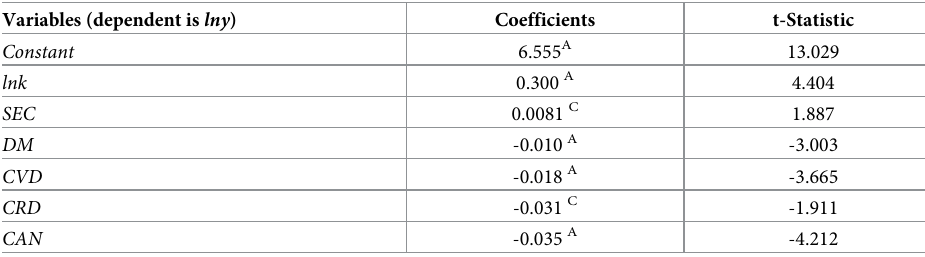
CAN -4.212 A, B, C indicate significance at 1, 5 and 10 percent